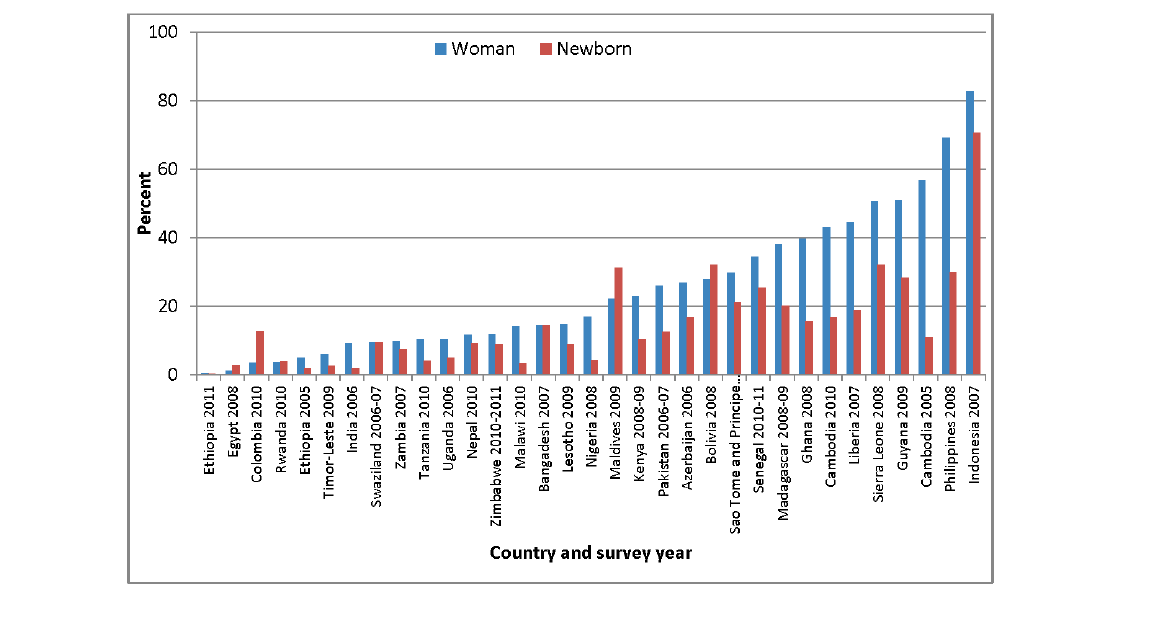
Figure 2. Proportion of home births for which women and babies received postnatal care within two days of delivery, DHS survey data 2005–2011 [ 18 ] .